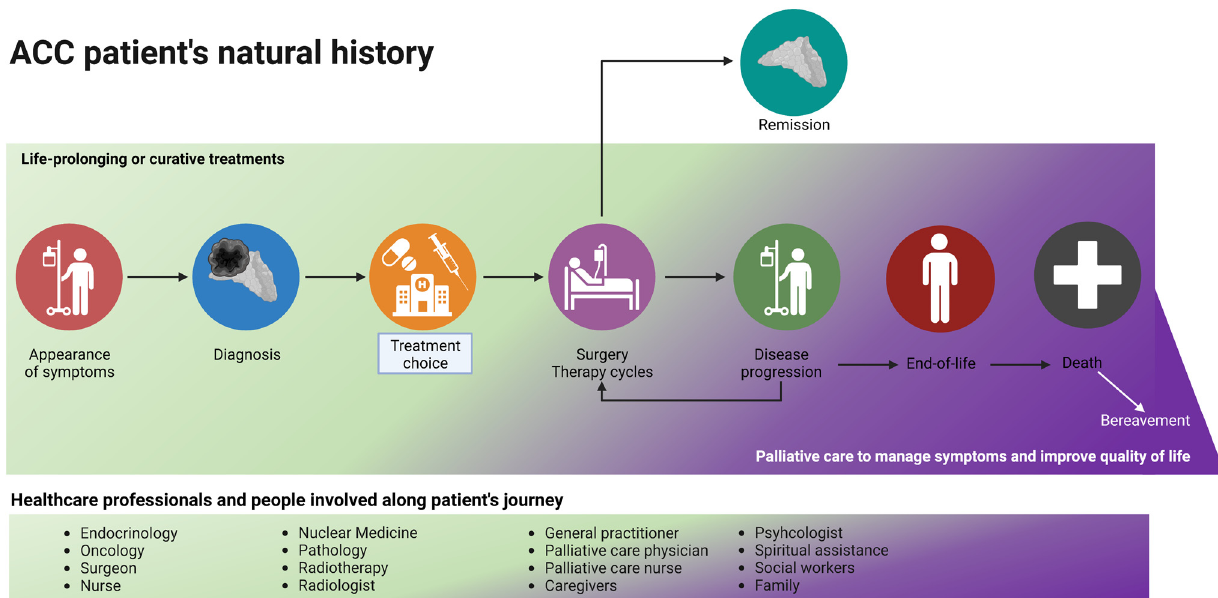
Figure 3. The journey of a patient with ACC: a palliative care evaluation should be considered early in the natural history of the disease, especially for patients with metastatic and advanced disease. During disease progression and the planning of second/third-line treatments, the time spent on life-prolonging treatment and on palliative care (in purple) should be equal. Curative treatment (in green) stops at the end-of-life phase, and palliative care continues after death (with family support). Created with BioRender.com.